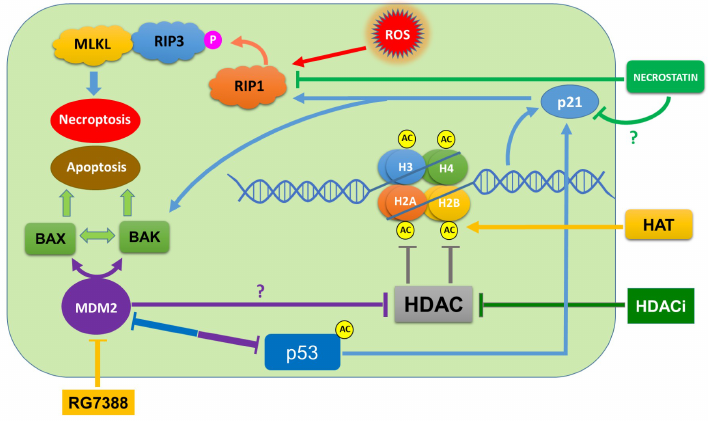
Figure 11. Various pathways that might be involved in SAHA- and RG7388-induced cell death. SAHA-induced necroptosis is mediated through phospho-RIP3, and RG7388-mediated apoptosis is possibly through p53- and p21-independent mechanisms but mediated through BAX and BAK.